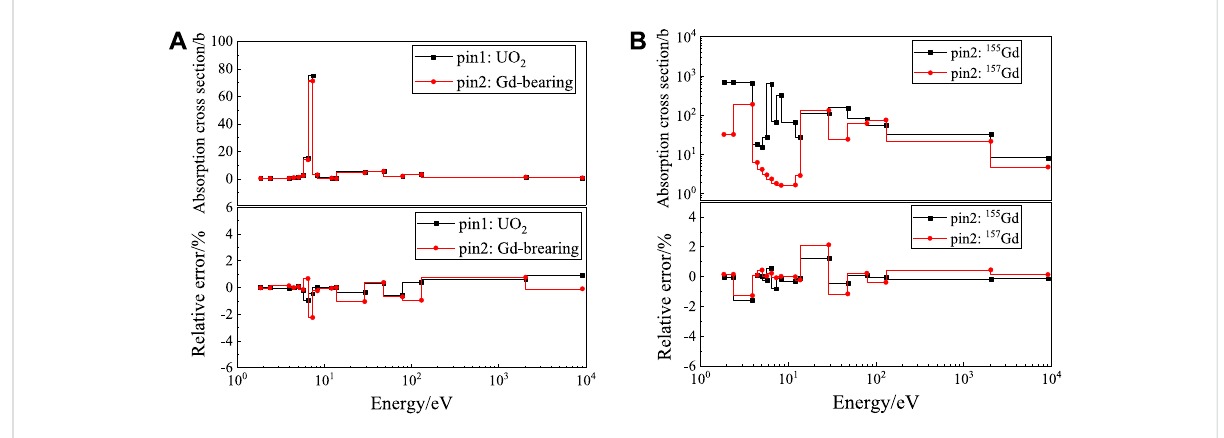
FIGURE 13 Relative deviation of absorption cross section for the 4 × 4 lattice: (A) 238 U; (B) 155 Gd and 157 Gd.